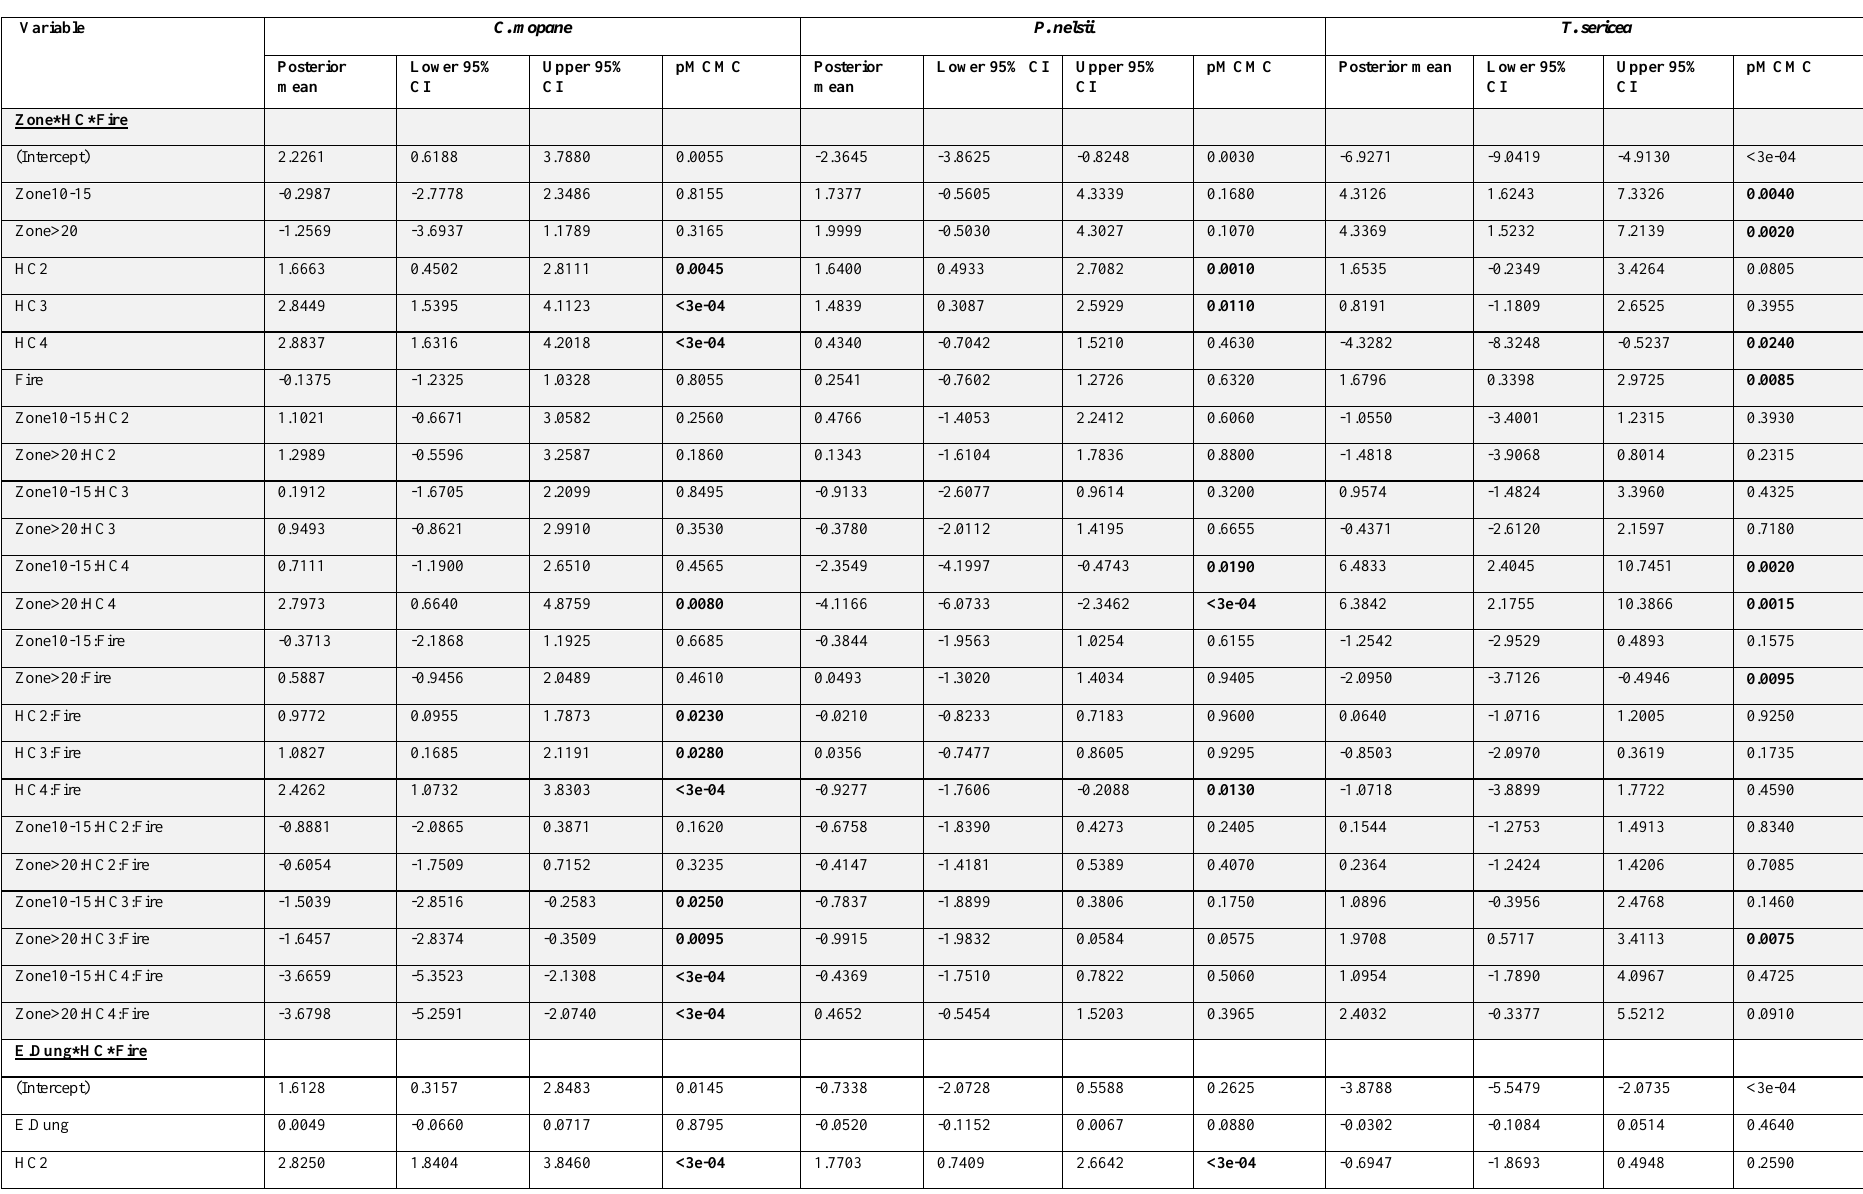
TABLE 2: Markov chain Monte Carlo analyses (Hadfield 2010) of the relationship between the height structure of the three most dominant tree species of the study area and distance zone from permanent water. Posterior means, 95% confidence intervals and p -values (< 0.05 in